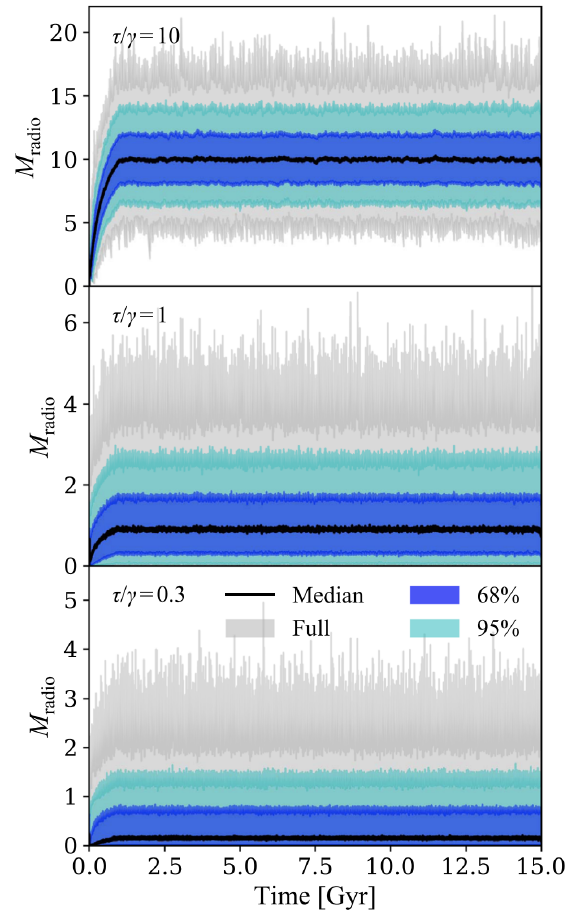
Figure 4. Previously published as Figure 6 in [57], ©AAS, reproduced with permission. Statistical distribution of the mass of an SLR in the ISM ( M radio ) as a function of galactic age, assuming each enrichment event ejects 1M (cid:12) of radioactive material. Different panels show results from our stochastic Monte Carlo framework using different τ / γ values, representing ratios between the SLR mean-life and the average time interval between enrichment